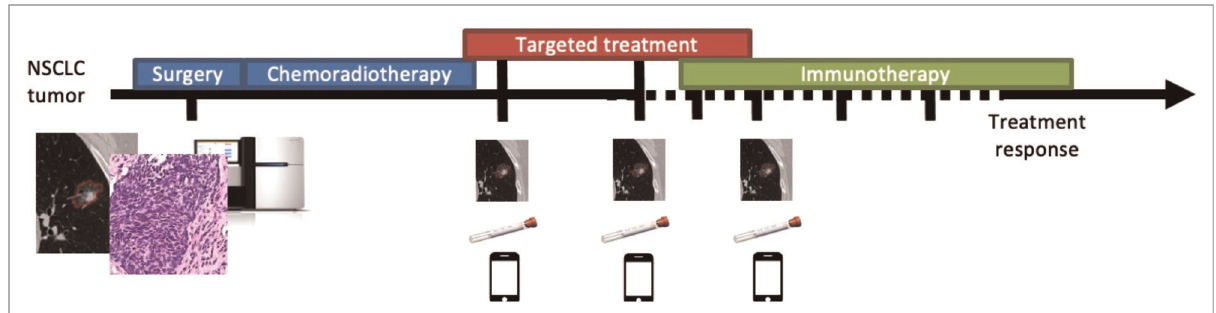
FIGURE 2 Longitudinal and multi-modal data capture for a lung cancer patient: timeline of a composite lung cancer patient showing possible treatment strategies and possible biomedical data